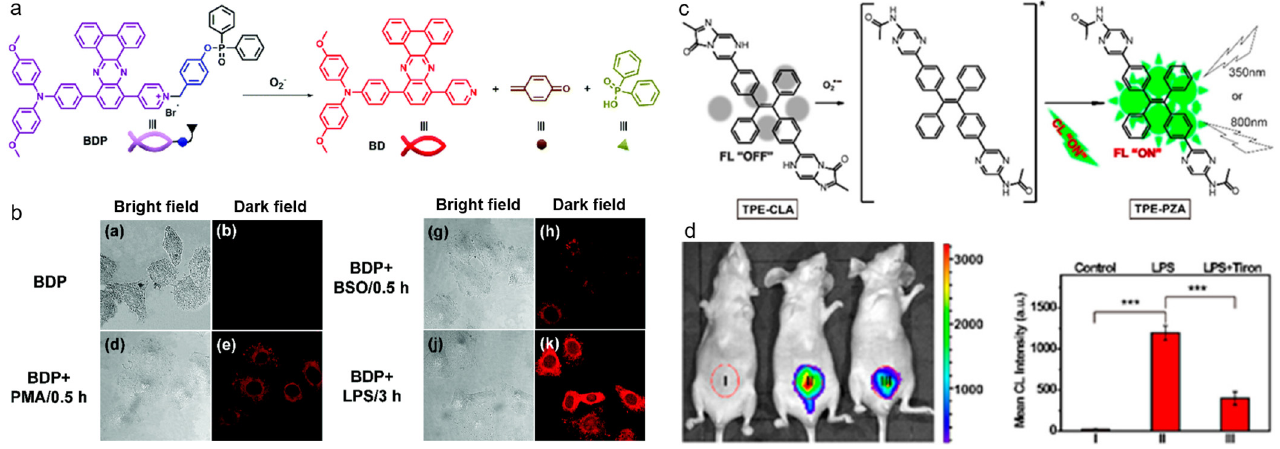
Figure 10. ( a ) Chemical structure of BDP and the O 2• − -activatable process; ( b ) CLSM imaging of HepG2 cells with different treatments (reproduced with the permission from ref. [141]. Copyright 2018, The Royal Society of Chemistry); ( c ) chemical structure and the O 2• − -response mechanism; ( d ) in vivo CL images and corresponding imaging intensity of LPS-induced inflammation in mice. *** p < 0.001. (Reproduced with the permission from ref. [142]. Copyright 2017, American Chemical Society).